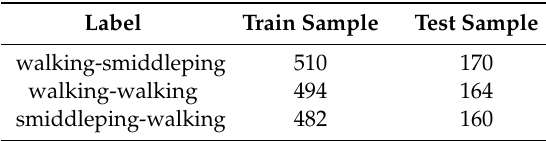
Table 11. Number of intention samples.